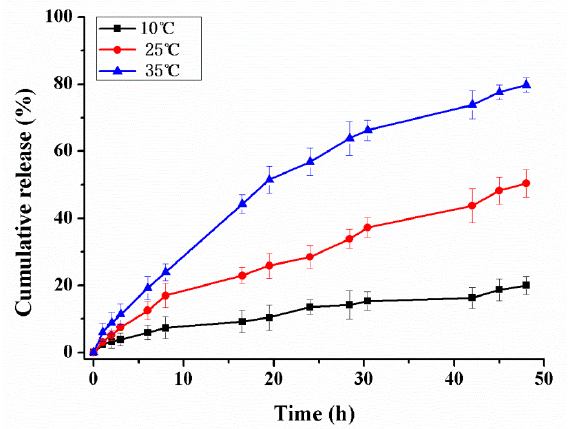
Figure 9. Pyraclostrobin released at different temperature at pH 6.8. Error bars correspond to standard errors of triplicate measurements.